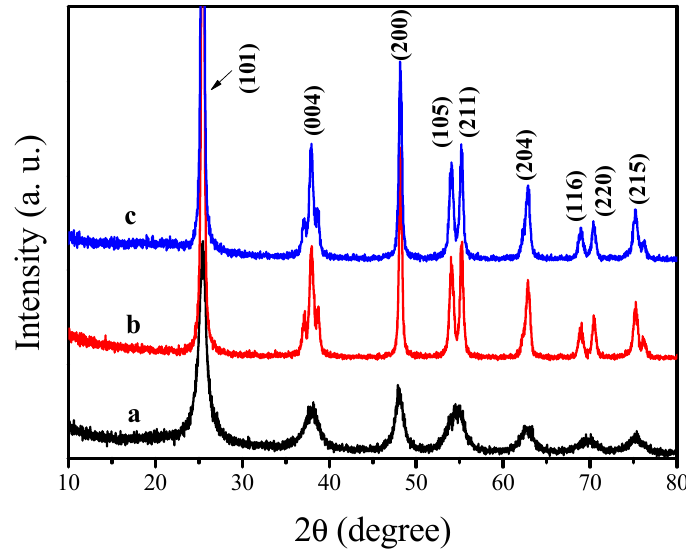
Figure 1. XRD patterns of ( a ) TNPs-1, ( b ) TNPs-2, and ( c ) TNPs-3. The size of the primary TiO 2 particles was further observed form the TEM images (Figure 2). The TEM images show that the TNPs-1 was dispersed and the TNPs-1 parti- cles were relatively regular in shape. The magnified image shows that the TNPs-1 was entirely tetragonal, with a size of 3–7 nm. The particle size distribution of the TNPs-1 was consistent with the results of the XRD analysis. However, the TNPs-2 and TNPs-3 parti- cles were not spherical but irregular, with a prolate or oblate shape. The particle sizes of